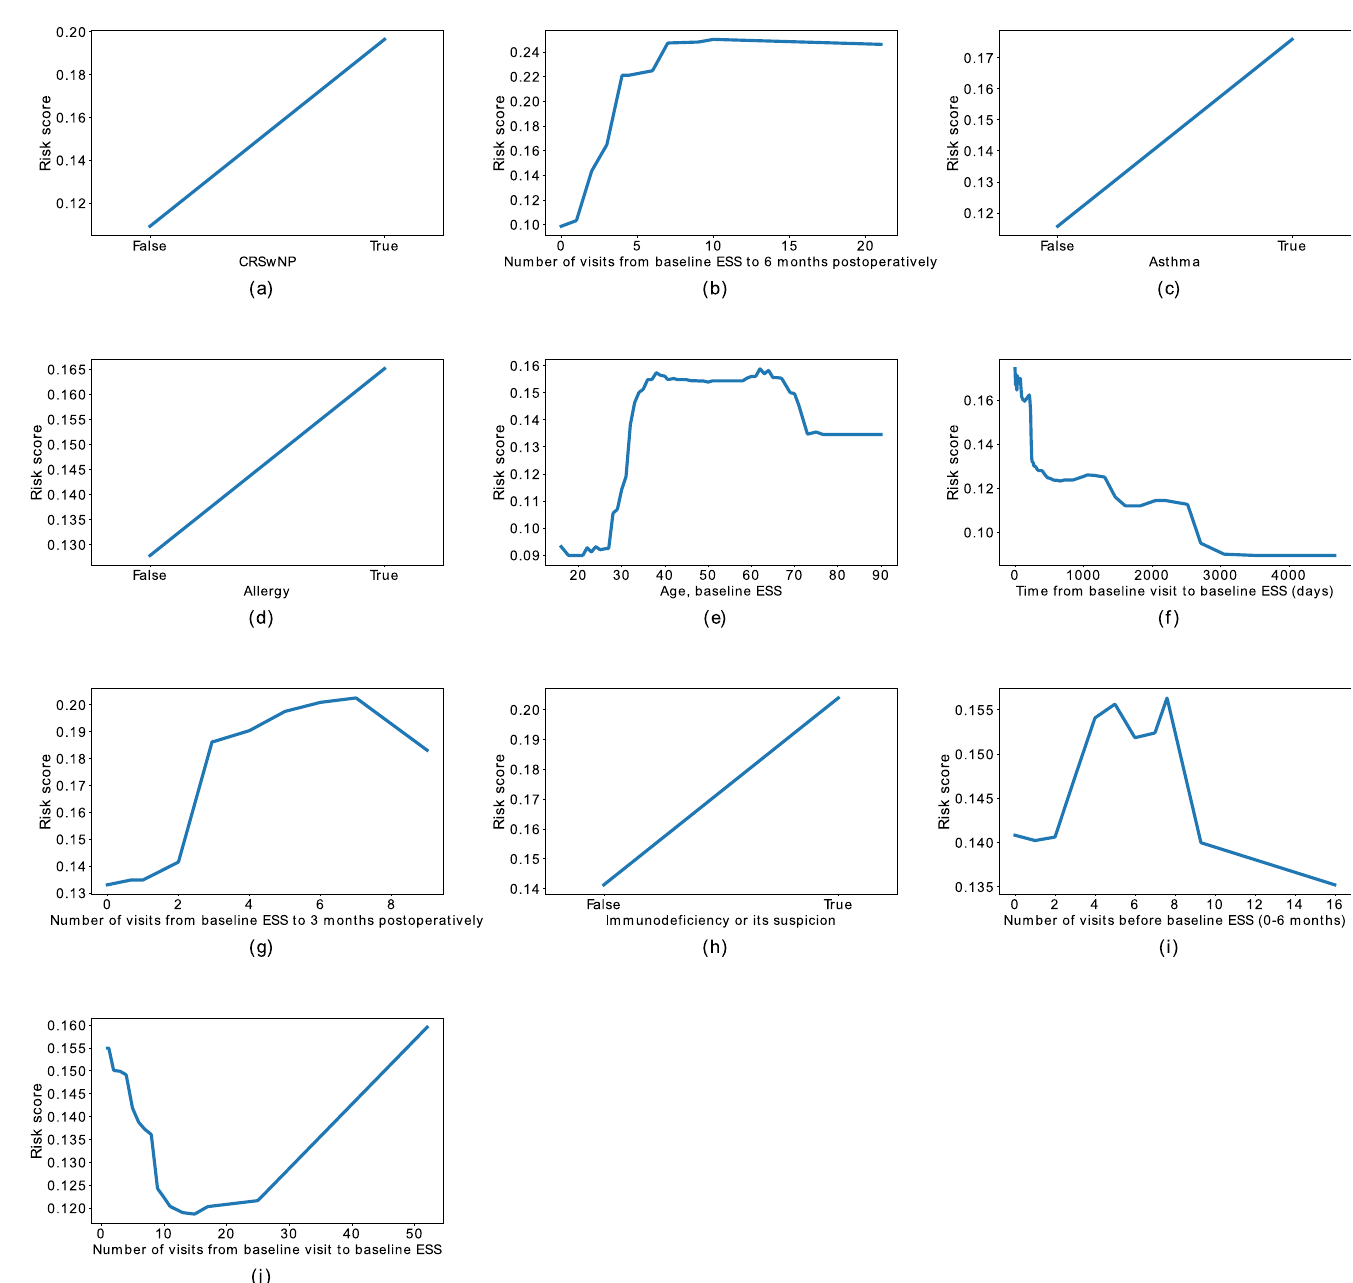
Fig 7. Partial dependence plots (PDP) for predicting revision ESS using the gradient boosting classifier of the ten variables with the highest SHAP values (Shapley or SHapley Additive exPlanations). ESS, endoscopic sinus surgery; CRSwNP, chronic rhinosinusitis with nasal polyps. See also Fig 6.